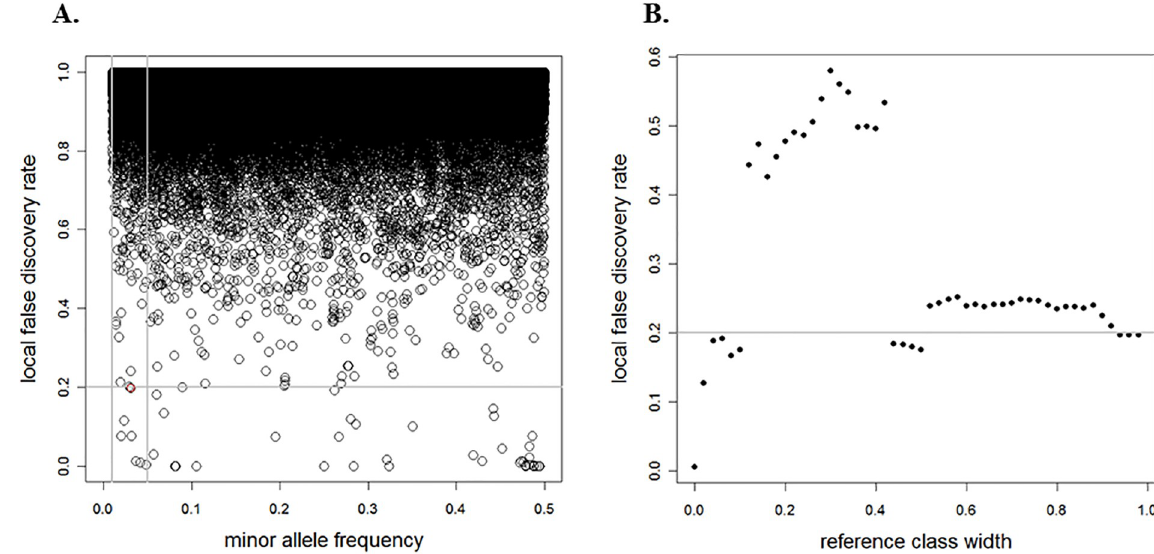
Fig 1. CAD data for LFDR estimates under the HB model versus the MAF x i (A) and reference class width (B) for a fixed MAF x i = 0.0306. The horizontal line represents the threshold of 0.2. The vertical lines in (A) indicate the symmetry around x